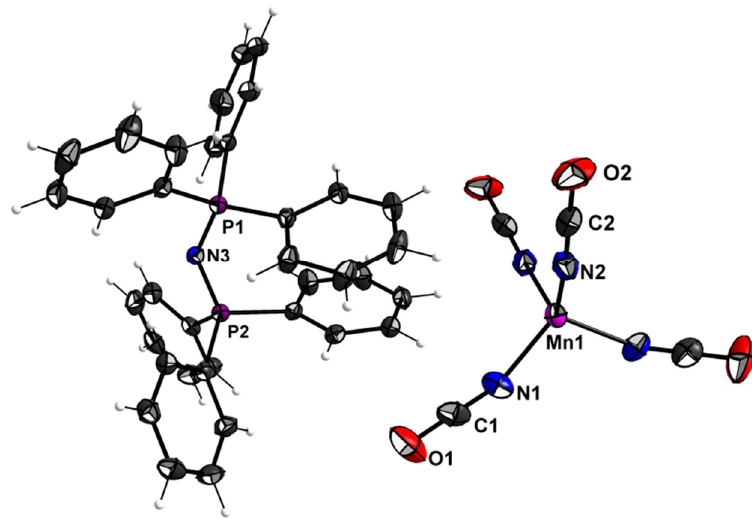
Figure 3. Molecular structure of ((Ph 3 P) 2 N) 2 [Mn(NCO) 4 ] with labeling of selected atoms. Thermal displacement ellipsoids are drawn at the 50% probability level.